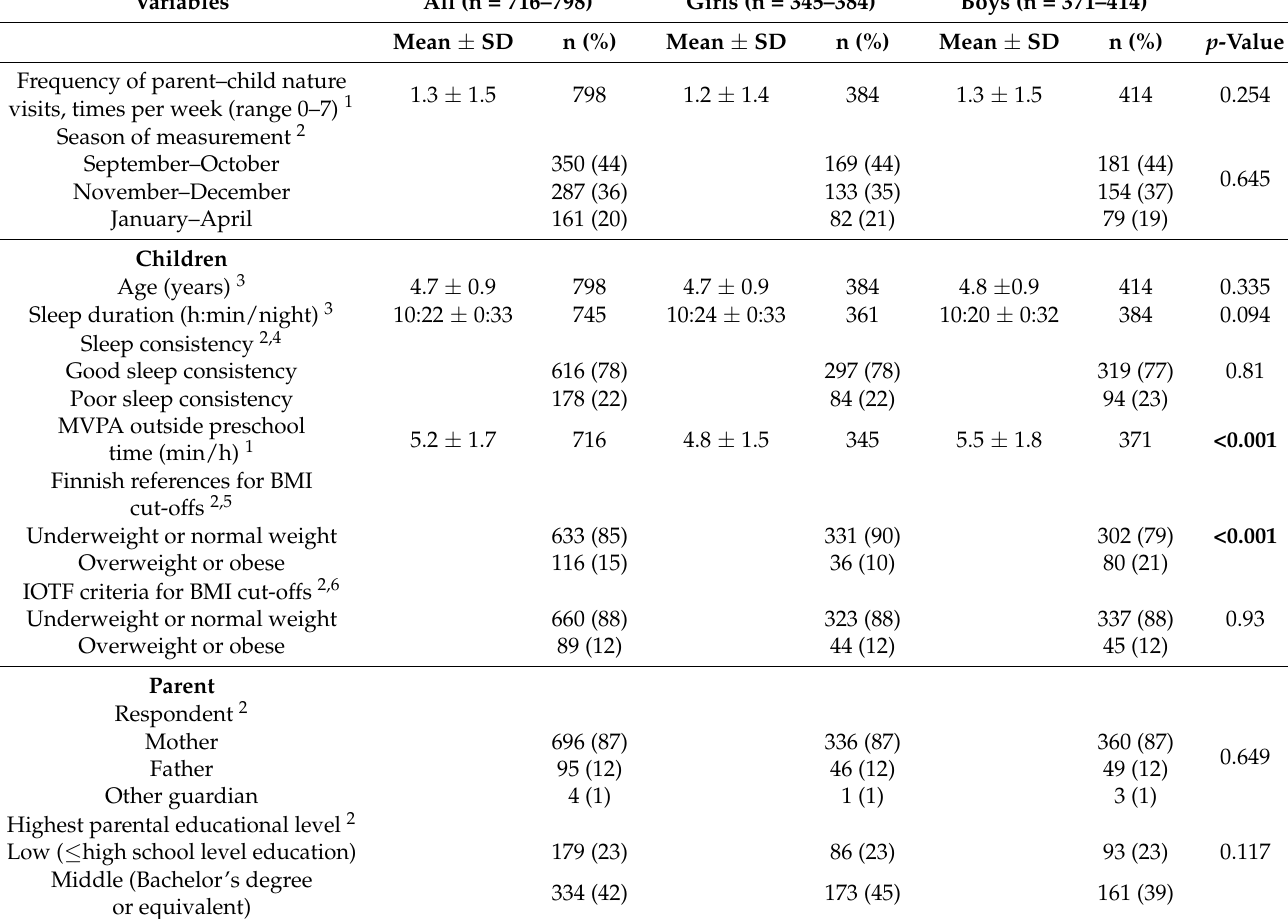
Table 1. Descriptive statistics of 798